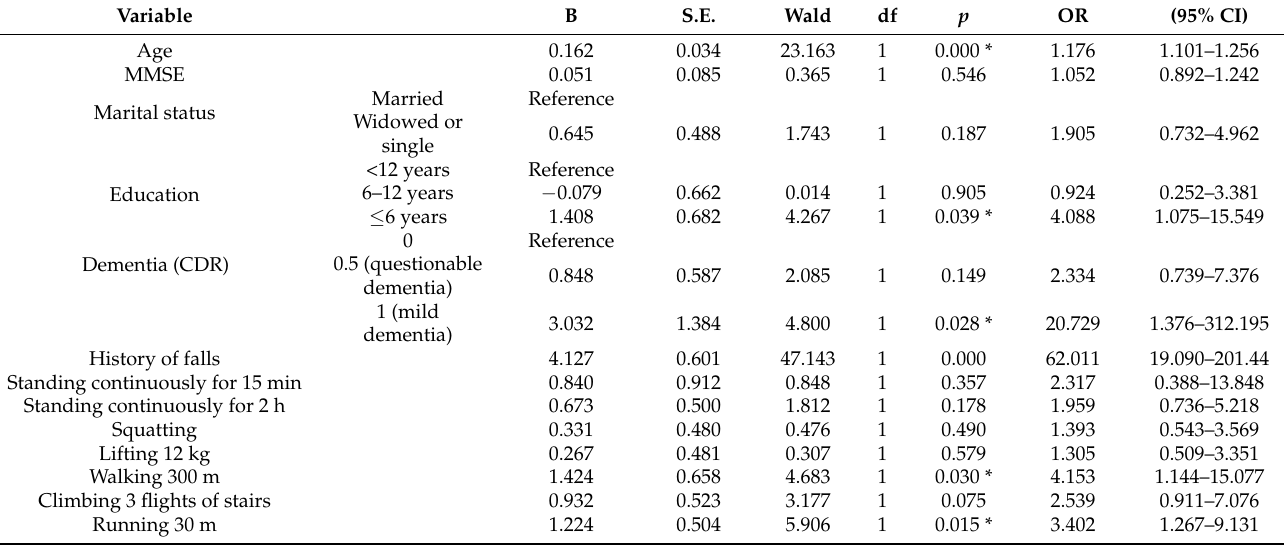
Table 3. Binary logistic regression models of risk factors for falling over the course of 1